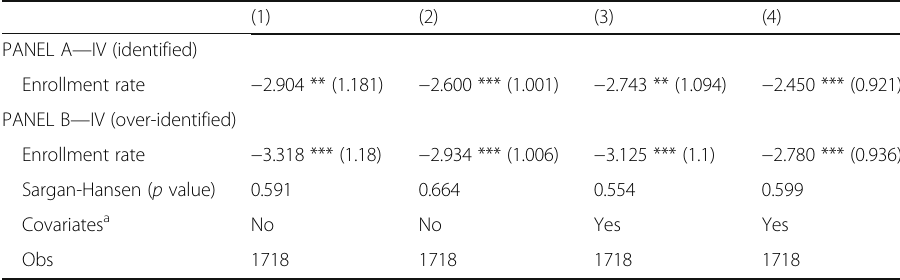
Table 9 The effect of enrollment rates on teenage fertility rates ( ‘ incapacitation ’ effect). 2SLS estimates — second stage (Eq.